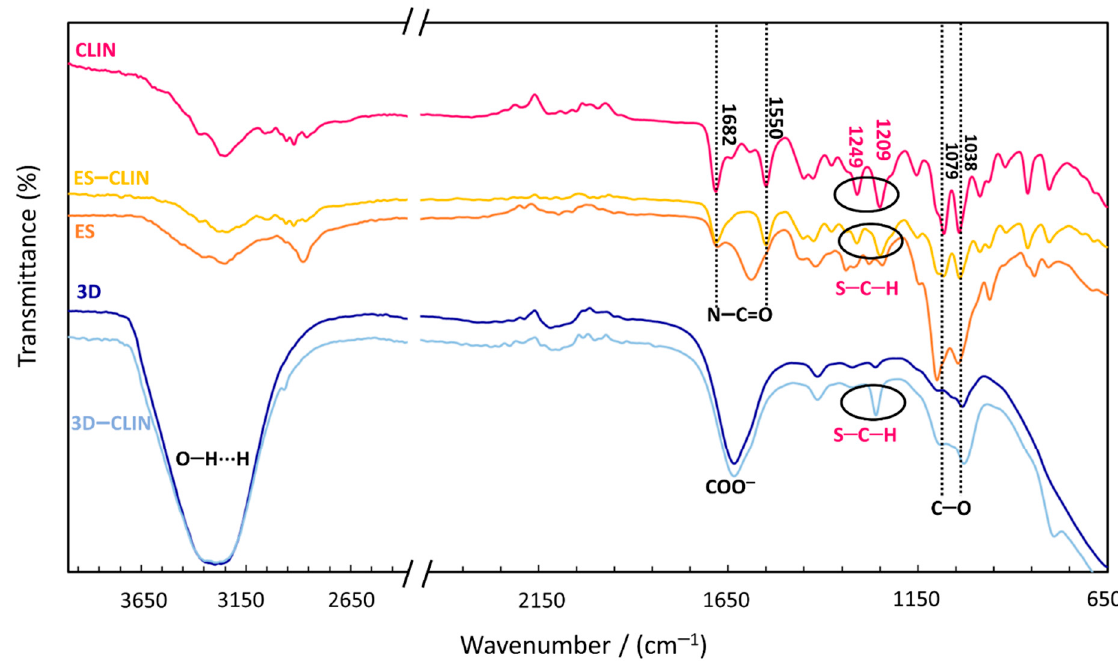
Figure 1. Attenuated total reflectance–Fourier transform infrared spectroscopy (ATR-FTIR) spectra of clindamycin (CLIN), the electrospun (ES), the ES-loaded with CLIN (ES–CLIN), the 3D-printed coating (3D), and the 3D-printed coating loaded with CLIN (3D–CLIN). CLIN-related peaks (S–C–H) in ES and 3D-printed polymer coatings are designated in ellipses.